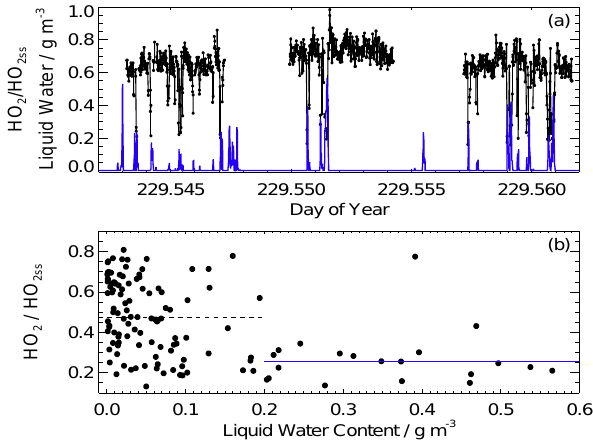
Fig. 16. (a) Time Series of HO 2 /HO 2 ss ratio (black) and liquid water (blue); (b) HO 2 /HO 2 ss ratio as a function of liquid water (gm − 3 ). The median HO 2 /HO 2 ss ratio is 0.4 and is shown as a dashed